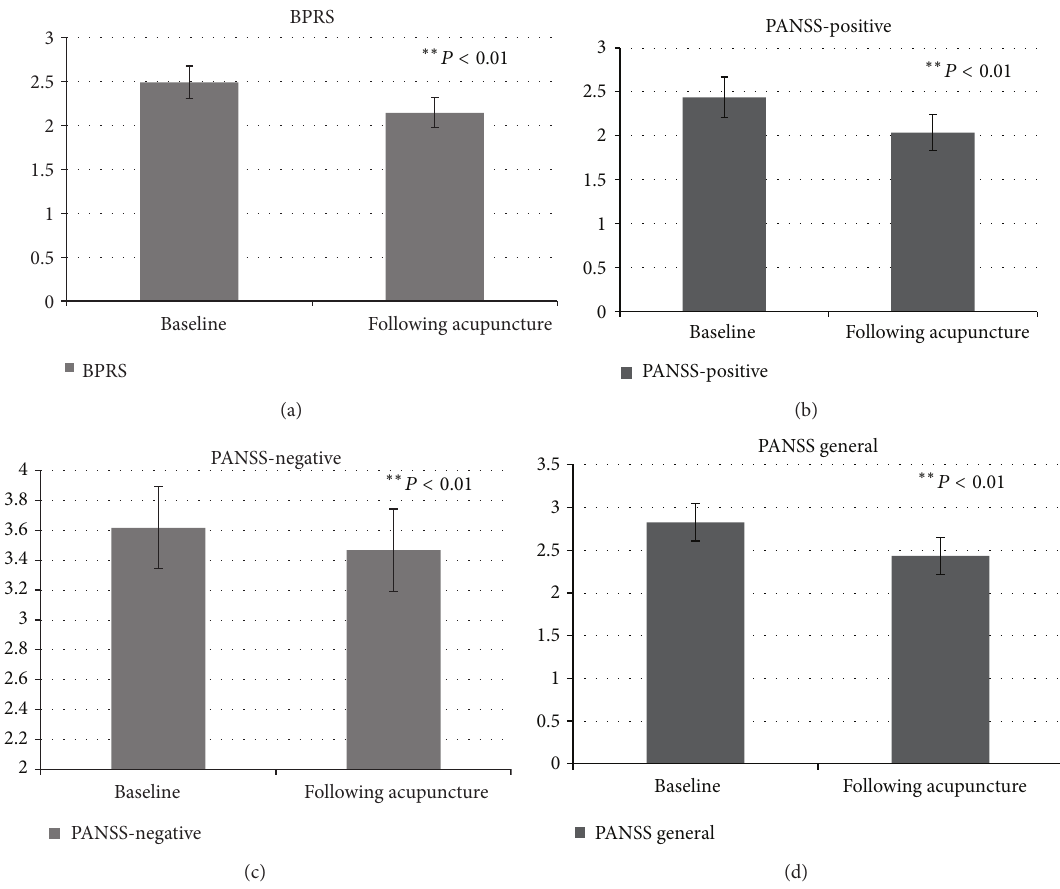
Figure 2: Objective psychopathology levels before and after acupuncture treatment: (a) general psychopathology score as recorded by the Brief Psychiatric Rating Scale (BPRS), (b) positive symptoms as measured by the Positive and Negative Syndrome Scale (PANSS), (c) negative symptoms as measured by the Positive and Negative Syndrome Scale (PANSS), and (d) general symptoms as measured by the Positive and Negative Syndrome Scale (PANSS).